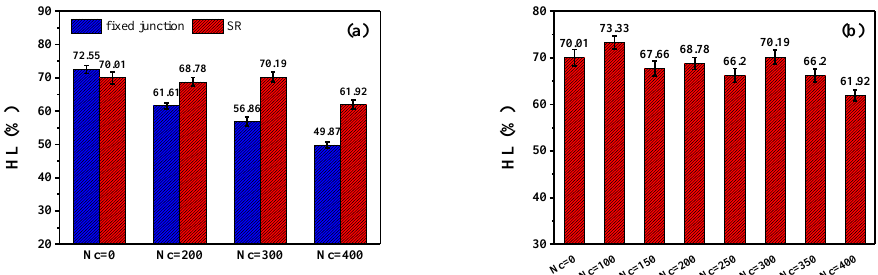
Figure 8. Hysteresis loss (HL) during the stretch-recovery deformation for different numbers of cross-linked bonds; Nc in ( a ) the fixed junction systems and SR systems and ( b ) HL of SR systems with a subdivided range of Nc from 0 to 400.